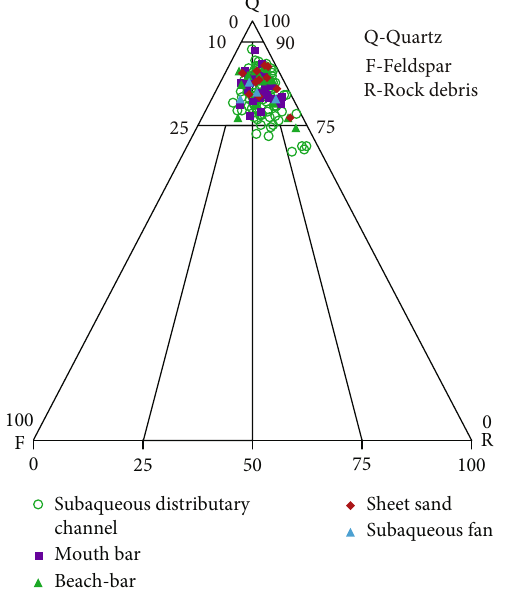
Figure 7: Detrital composition of sandstones of di ff erent w (ternary plot refers to the sandstone microfacies in E 2 classi fi cation standard of Folk